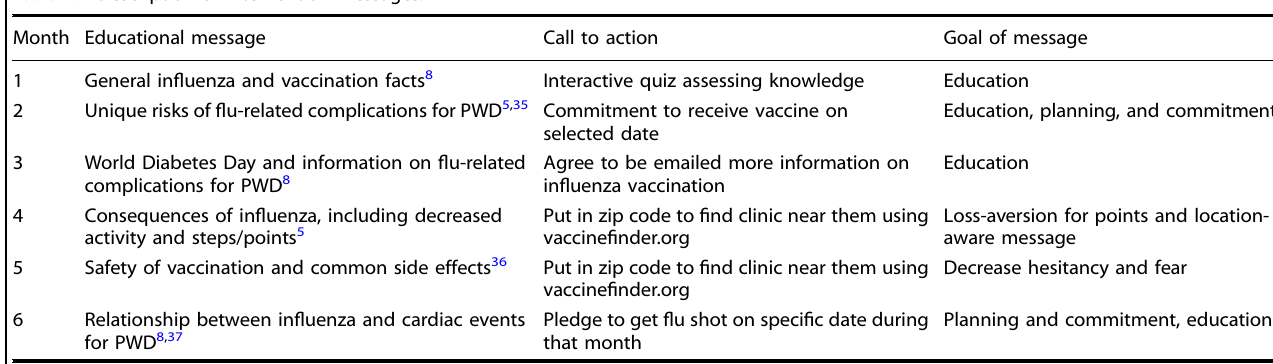
Table 2. Description of intervention